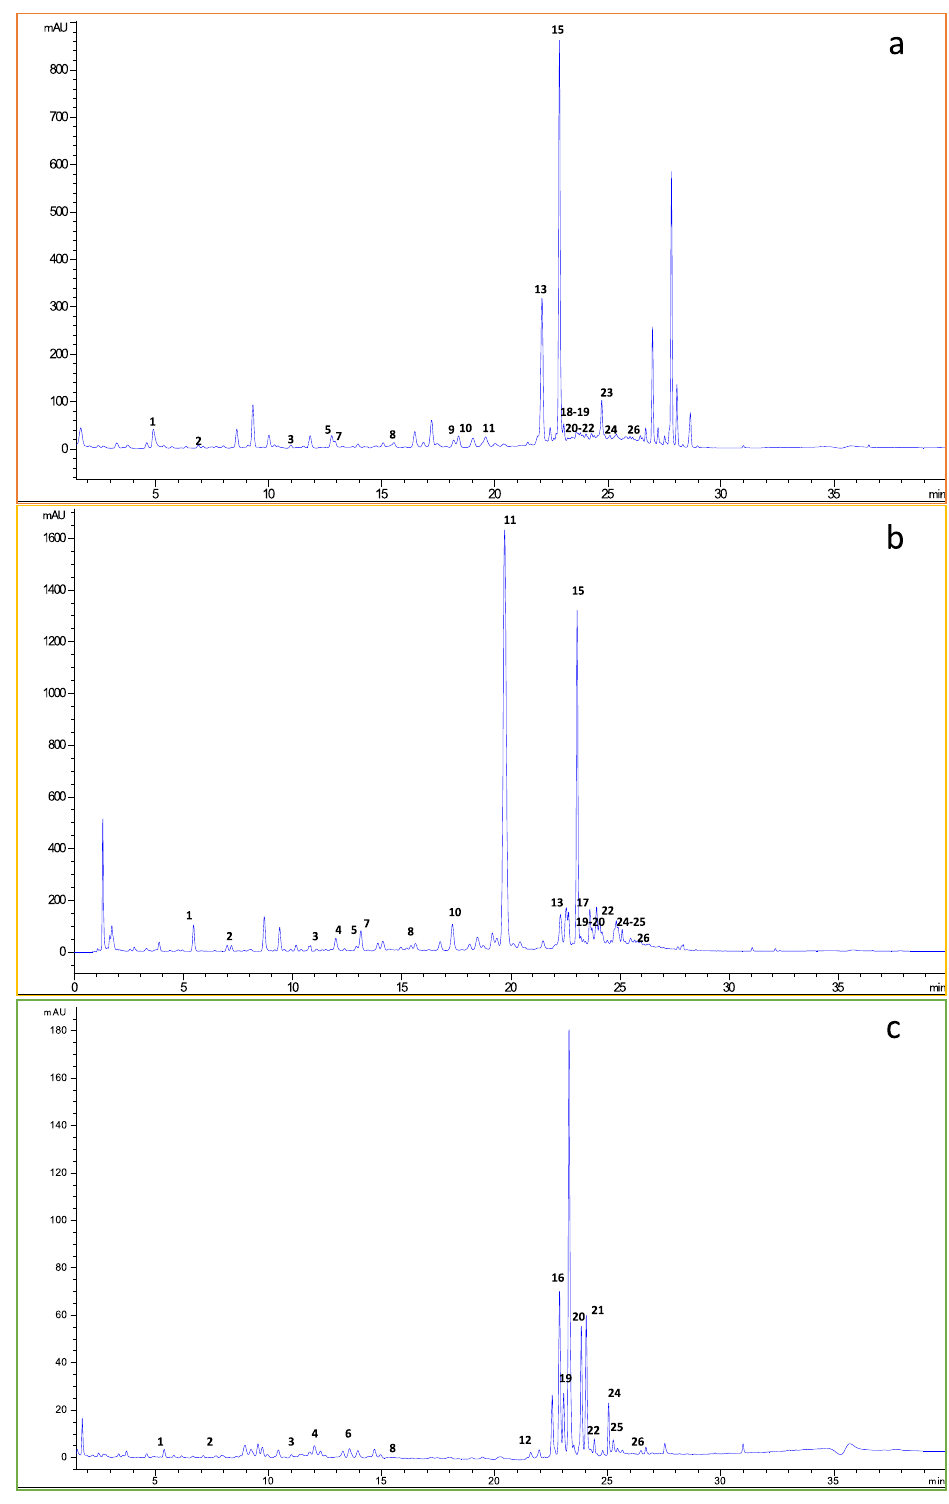
Figure 1. HPLC-DAD chromatograms of fruit by-products ( a ) orange, ( b ) lemon, and ( c ) apple, recorded at 278 nm.